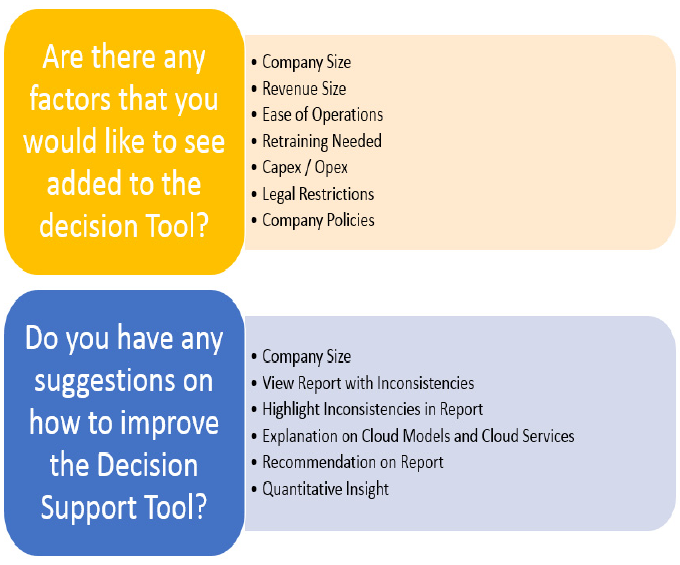
Figure 21. Evaluator’s suggestions.